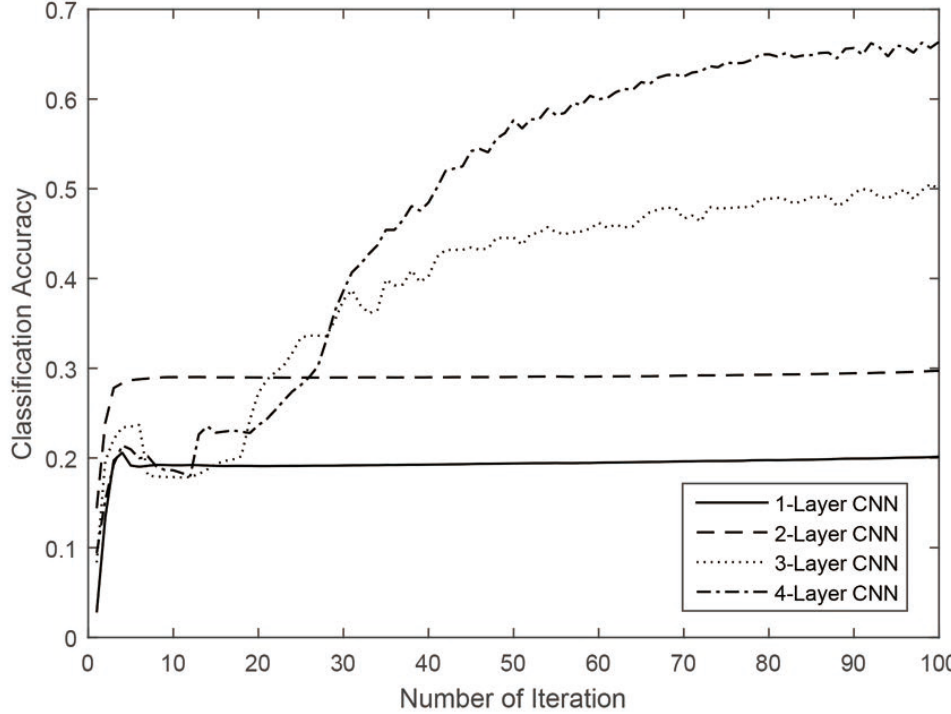
Figure 5. Overall accuracies of Indian Pines dataset classified by CNN under different depths.